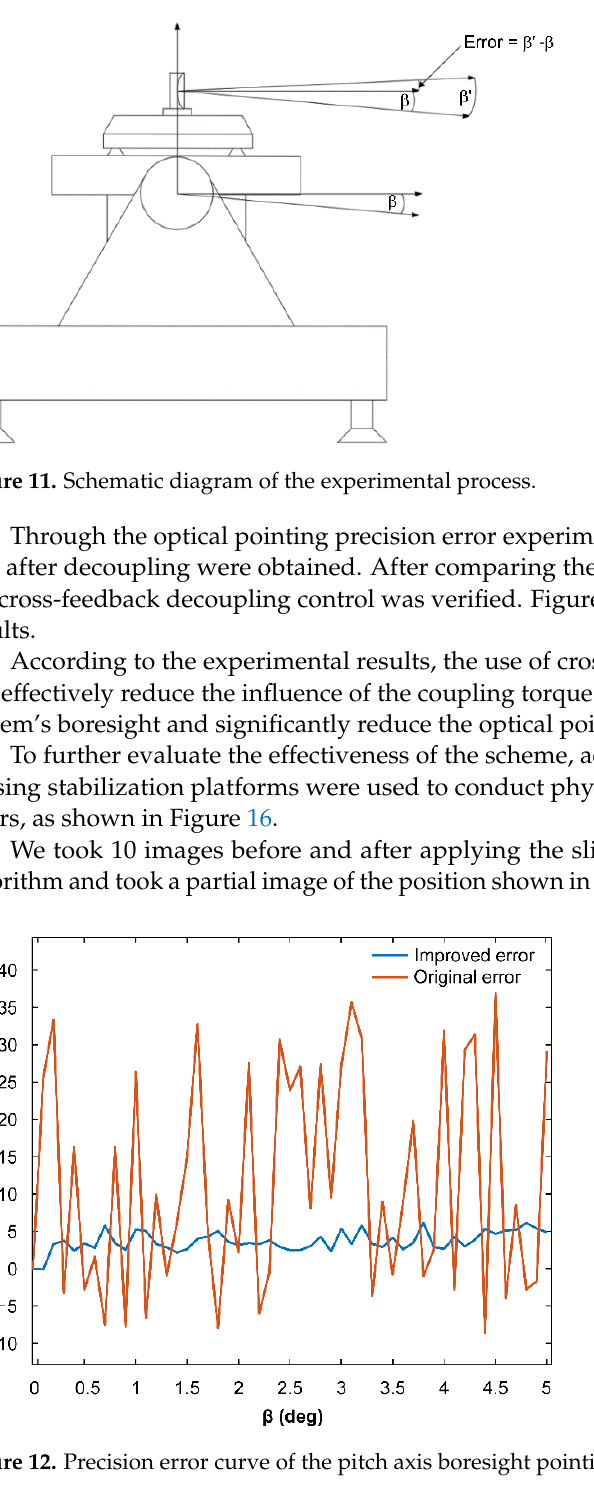
Figure 12. Precision error curve of the pitch axis boresight pointing.